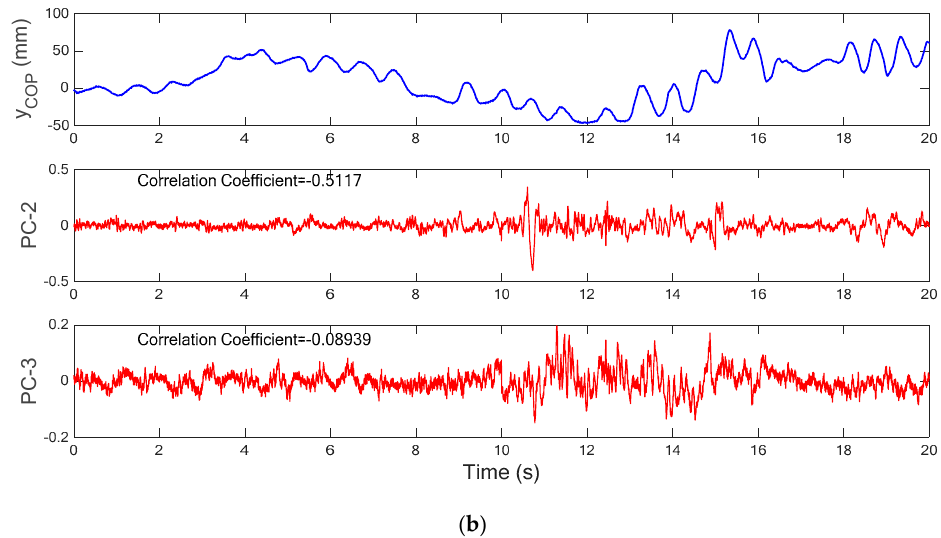
Figure 9. ( a ) Comparison between COP in the Y-axis and first principal component of acceleration signals, ( b ) Comparison between COP in the Y-axis, second and third principal components of acceleration signals.